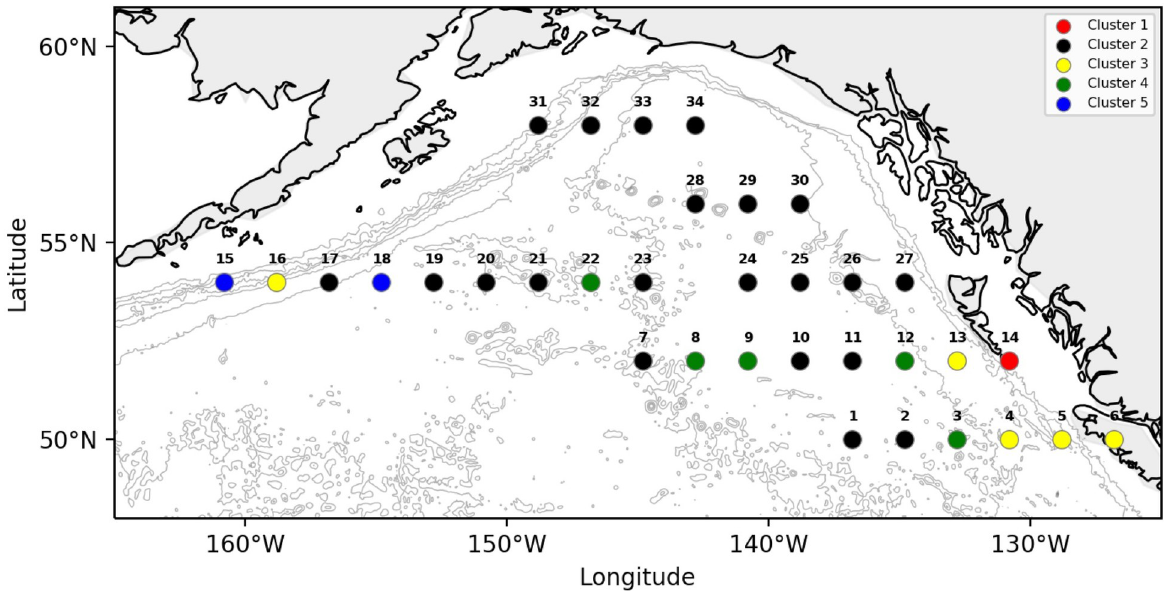
Fig 4. Spatial organization of five distinct clusters across the study region. The centerpoint of each bin is color-coded by cluster ID and mapped onto bathymetric contours depicting on-shelf and off-shelf regions of the GoA basin. Data points are numbered from East-West and South-North.